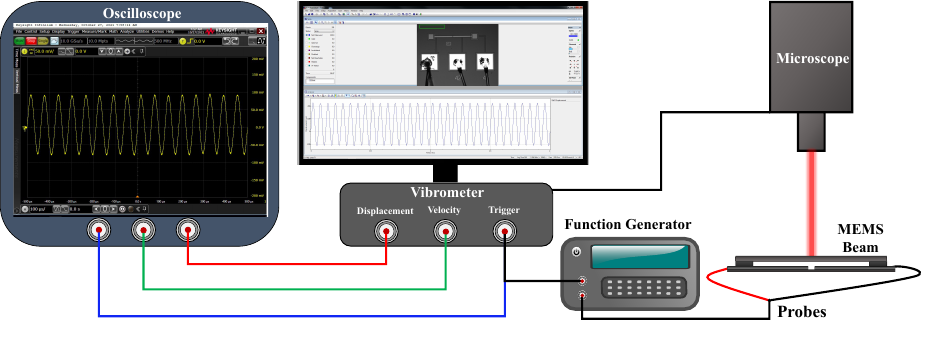
Figure 3. A schematic of the experimental setup.